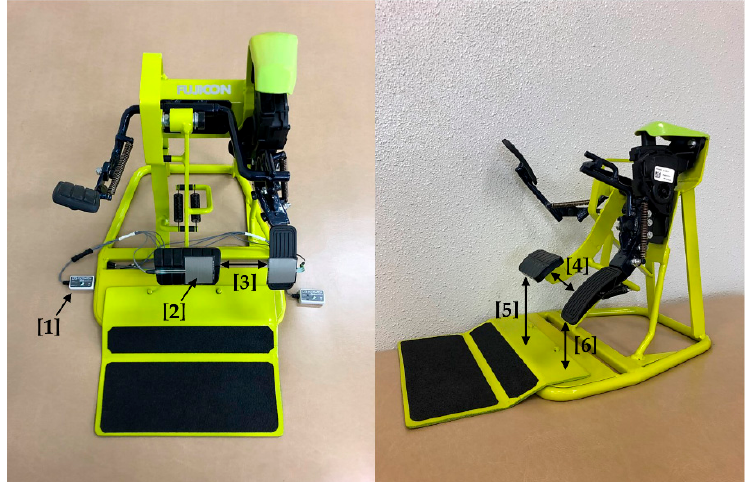
Figure 1. Pedals used in the experiment: [1] foot switch; [2] pressure sensor; [3] distance between the pedals of 73 mm; [4] height difference between the pedals of 30 mm; [5] brake height of 110 mm; [6] accelerator height of 75 mm.